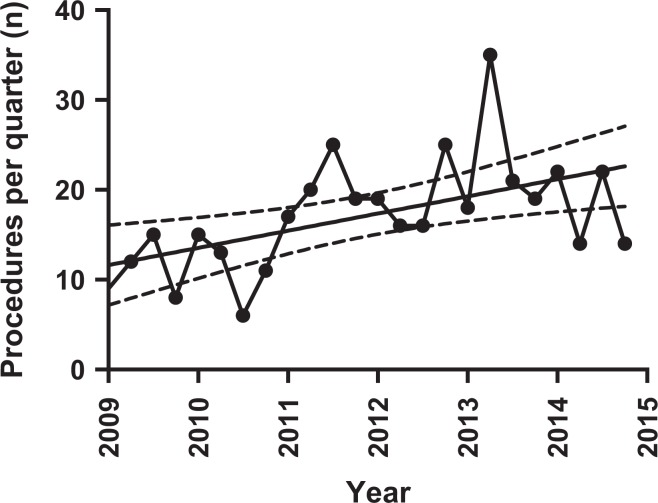
Change in number of ACJE procedure performed over time (Spearman r = 0.573, p = 0.003, solid line = linear regression). ACJE: acromioclavicular joint excision.